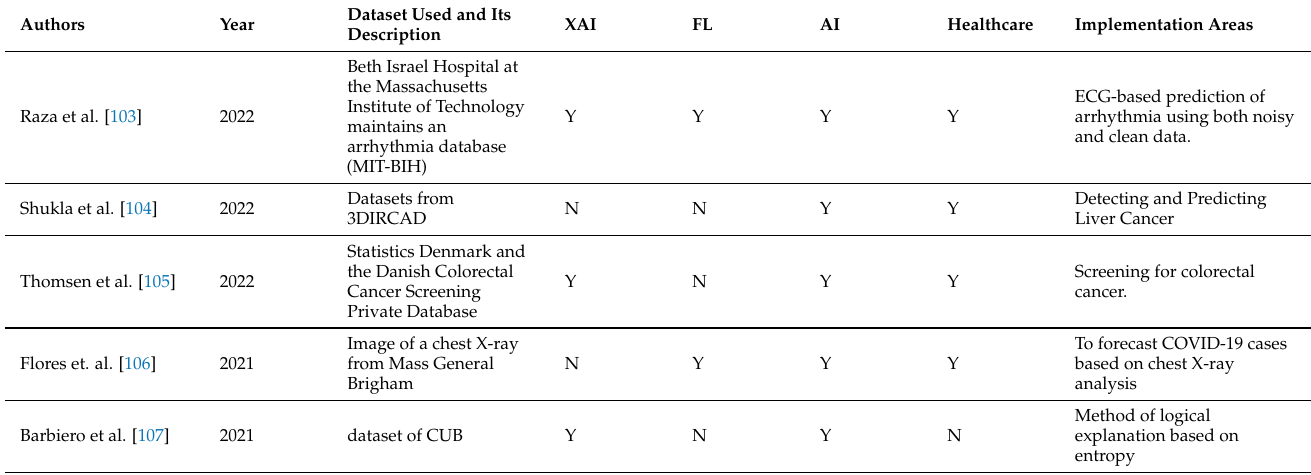
Table 9. Dataset summary of FL works with ML/DL and XAI in